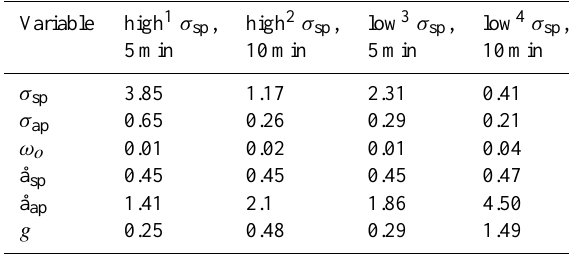
Table 2. Representative uncertainty